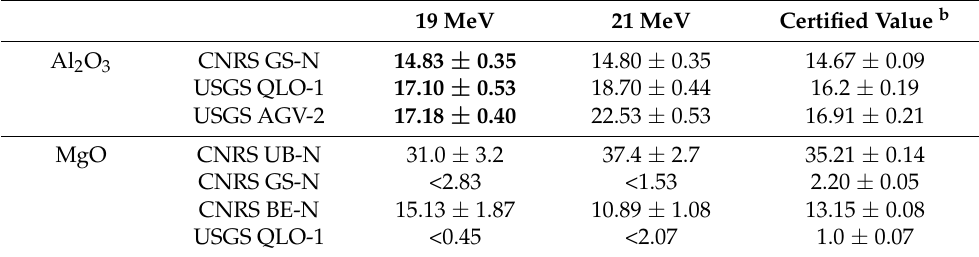
Table 5. Contents of Al and Mg (recalculated to oxides, wt.% ± U a ) determined by IPAA in